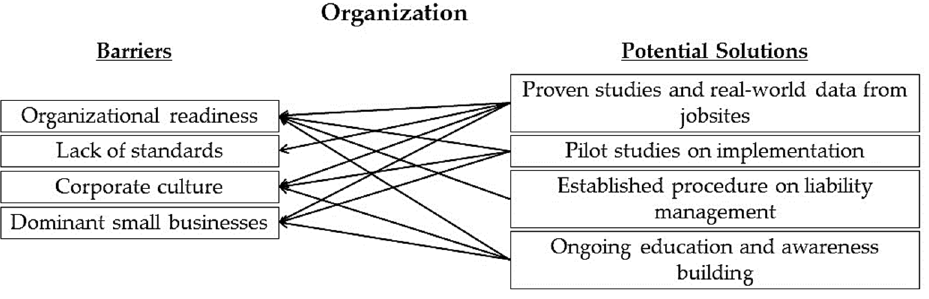
Table 6. Summary of policy/regulation category outcomes.